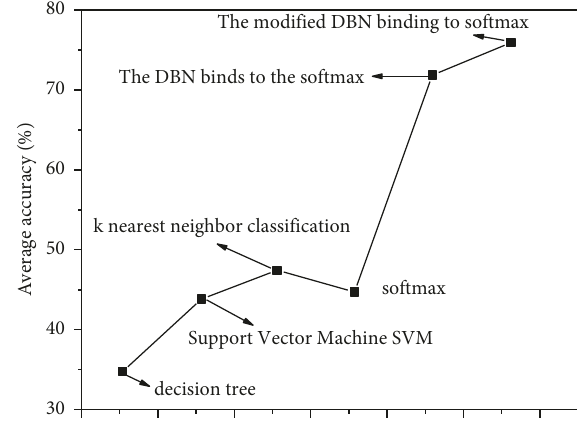
Figure 6: Average accuracy of music genre recognition and